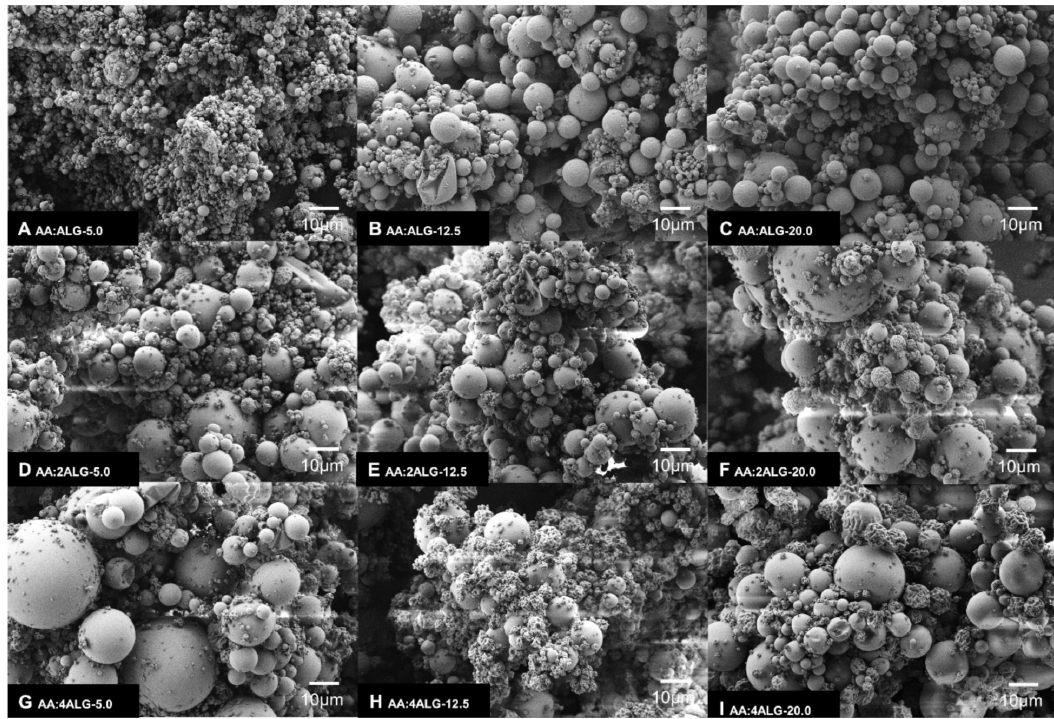
Figure 2. FE-SEM images of AA:ALG-based microparticles from 5 g L − 1 to 20 g · L − 1 of total dispersed solids and 1:1, 1:2 to 1:4 AA:ALG-polymer ratio; ( A ) AA:ALG-5.0, ( B ) AA:ALG-12.5, ( C ) AA:ALG-20.0, ( D ) AA:ALG-5.0, ( E ) AA:2ALG-12.5, ( F ) AA:2ALG-20.0, ( G ) AA:4ALG-5.0, ( H ) AA:4ALG-12.5, ( I